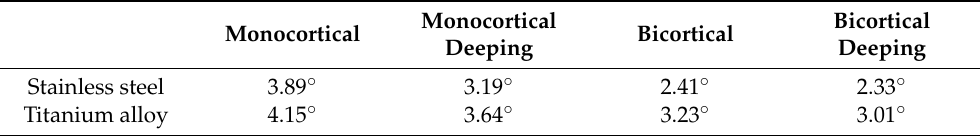
Table 4. Mean degree of bending of the miniscrew implants for the skull. Model with midpalatal suture for all 4 anchorage